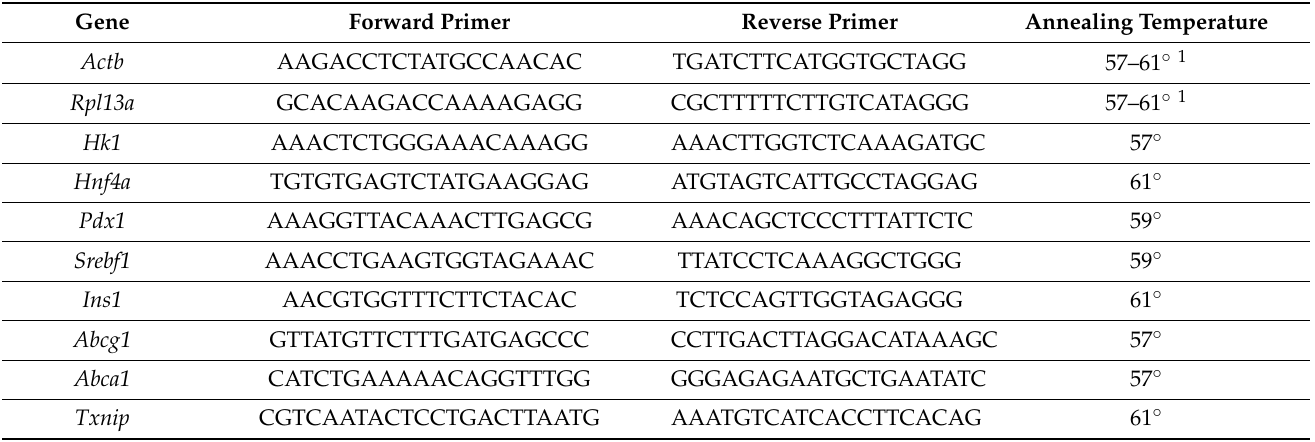
Table 2. Primers for qPCR experiments in BRIN-BD11 cells.